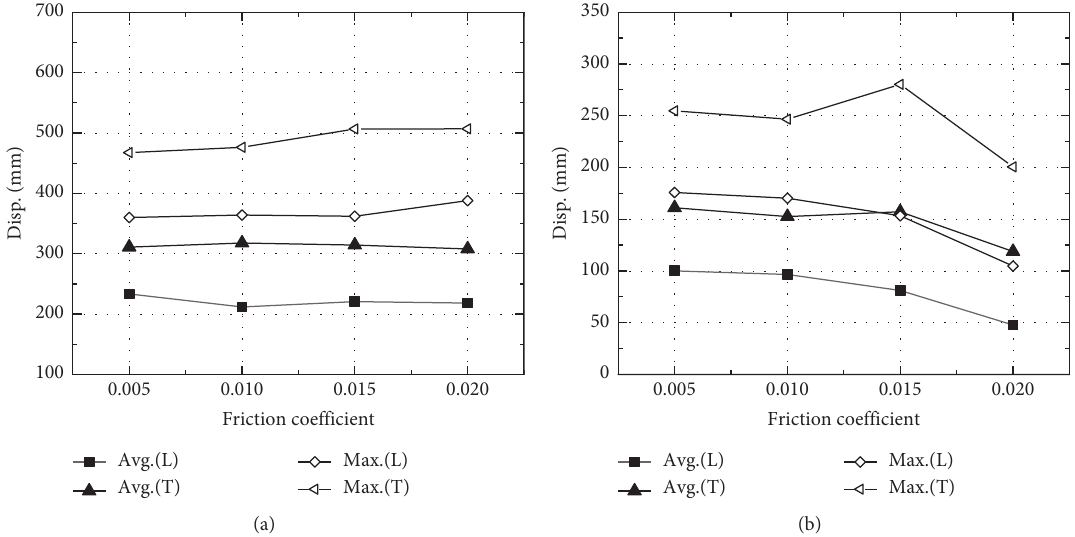
Figure 20: Effect of C T on the seismic displacements of bearings. (a) Maximum displacement. (b) Residual displacement.